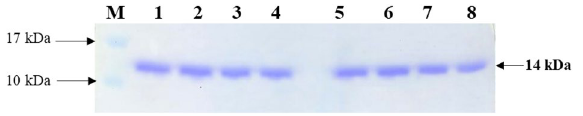
Figure 1. SDS-PAGE of the purified cyt c . Lanes M: Marker, 1–2: labeled WT cyt c, 3–4: labeled L94G mutant, 5–6: unlabeled WT cyt c and 7–8: unlabeled L94G mutant. Full gel image has been provided as Figure